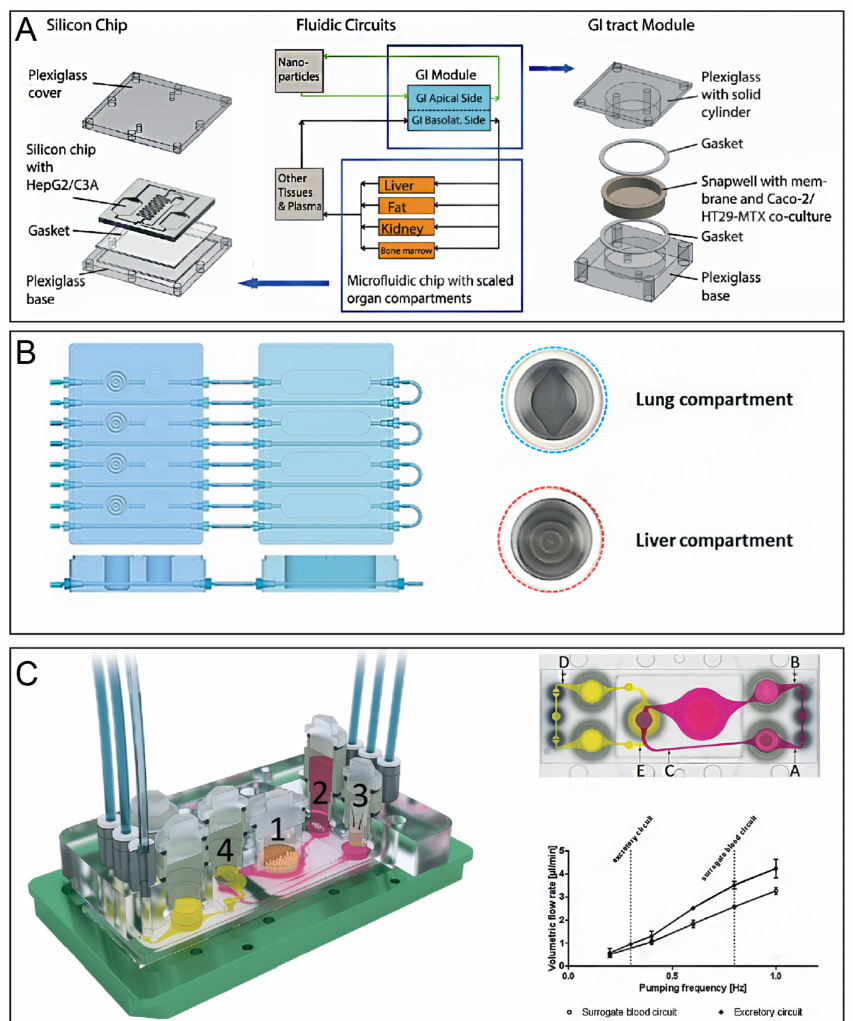
Figure 5. ( A ) Gastrointestinal tract and liver tissue system construct by combining the human intestinal epithelium and liver represented by coculture of enterocytes (Caco-2) with mucin-producing cells (TH29-MTX) and HepG2 / C3A cells. Reproduced with permission from [109]. ( B ) Lung / liver-on-a-chip, in which liver spheroids were connected in a single circuit and normal human bronchial epithelial cells were cultured at the air-liquid interface. Reproduced with permission from [98]. ( C ) The microfluidic four-organ-chip device. (i) 3D view of the device comprising two polycarbonate cover plates, a PDMS-glass chip accommodating a surrogate blood flow circuit (pink), and an excretory flow circuit (yellow). Numbers represent the four tissue culture compartments for the intestines (1), liver (2), skin (3), and kidney (4). (ii) Central cross-section of each tissue culture compartment aligned along the interconnecting microchannel. (iii) Average volumetric flow rate plotted against the pumping frequency of the flow circuit. Reproduced with permission from